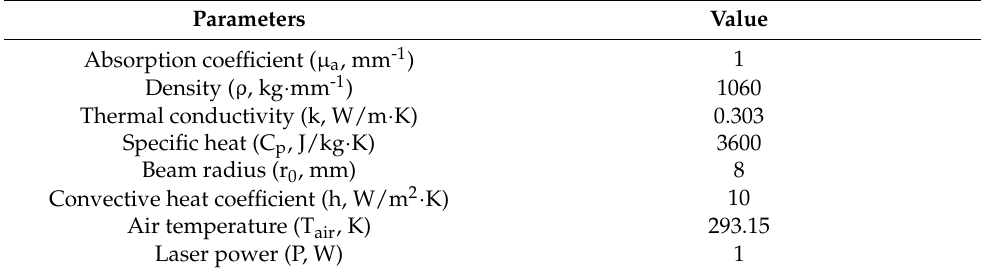
Table 1. Summary of thermo-physical properties used for numerical simulation [18–20]. Parameters